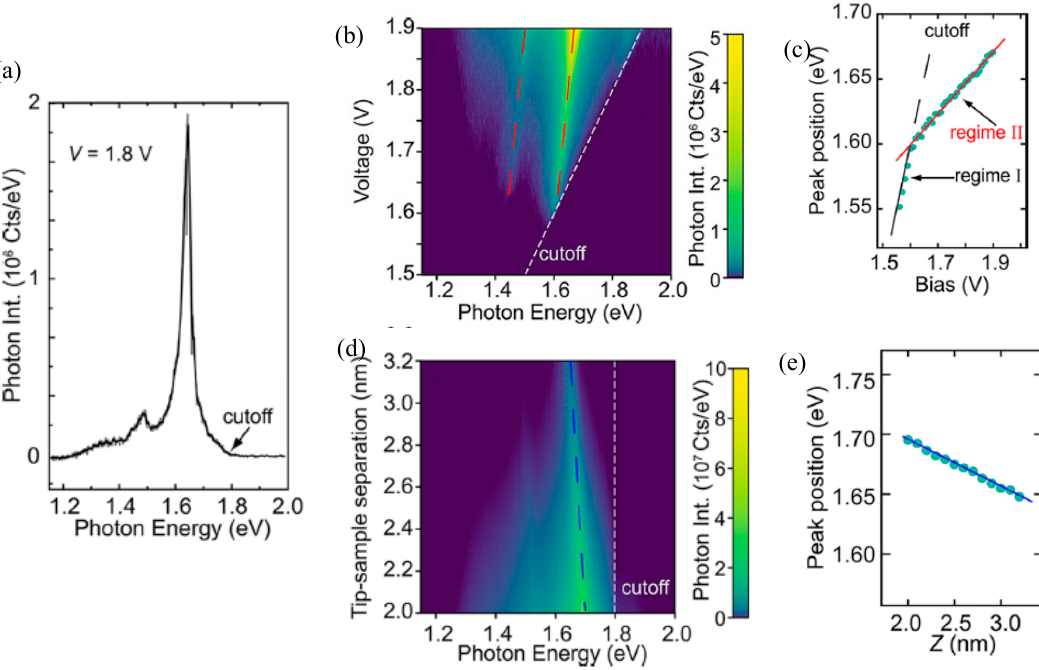
Figure 12. ( a ) Shows the electroluminescence spectrum of C-terminated GNRs. ( b ) and ( d ) show the characteristics of STM emission and voltage dependence (z = 2.3 nm) and tip distance (V = 1.8 V); for above the threshold voltage V > 1.53 V, no emission is observed. Above the threshold voltage, both vibronic and central peak is observed. At higher voltage (V > 1.9 V), no further spectral features were observed. ( c ) and ( e ) confirm the shift in emission line as a function of Z and V, respectively [140].